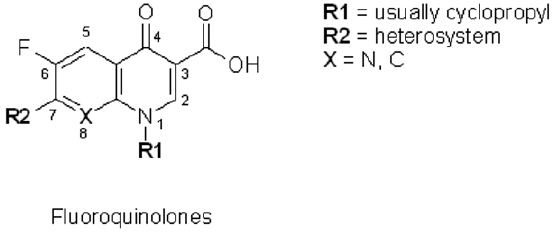
Figure 1. Generic structure of